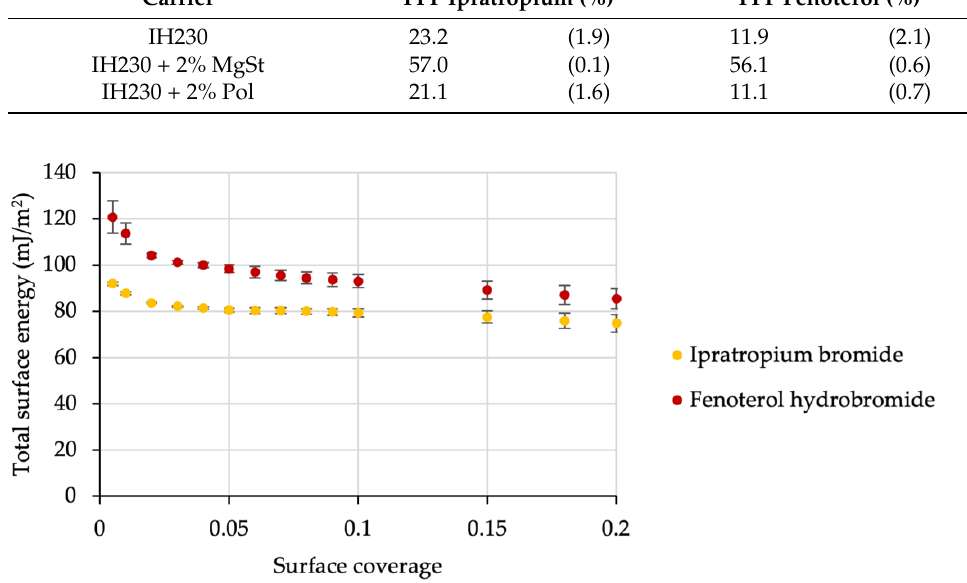
Figure 3. The distribution of total surface energies from the respective model APIs of this study. n = 3, error bars denote standard deviation. n = 3, error bars denote standard